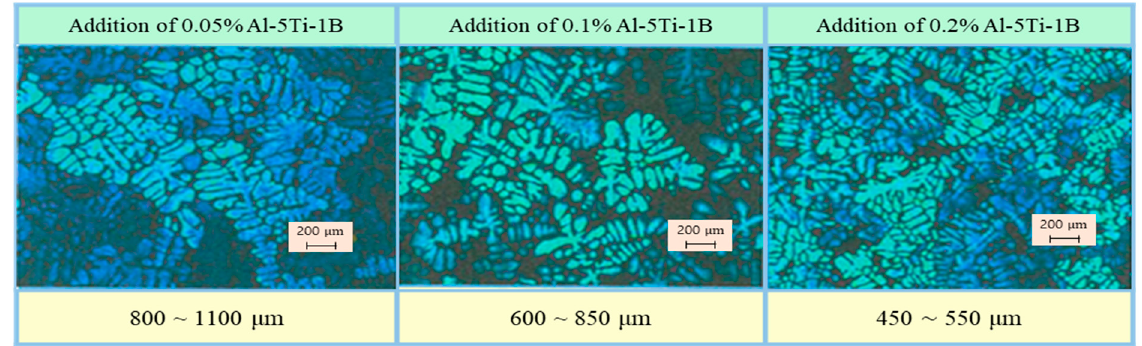
10 of 19 Figure 8. Grain size of AC4CH without grain control after refinement by Si.